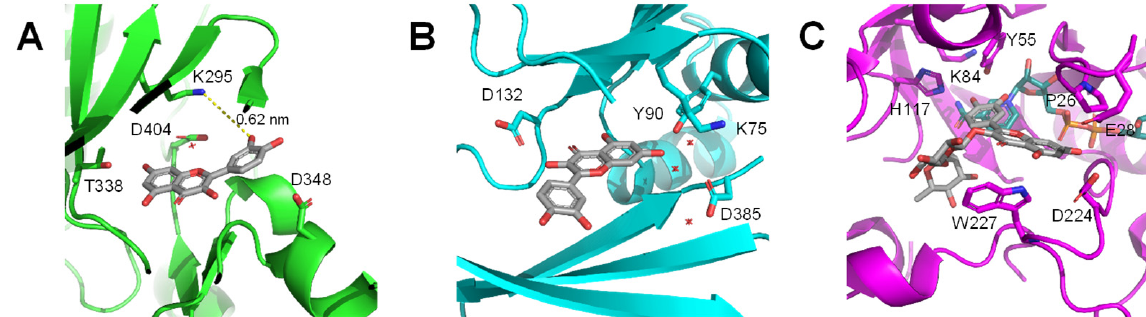
Figure 5. Interactions between flavonoid ligands and proteins from X-ray crystal structures; residues that could either form adducts or be oxidized by flavonoids are labeled. ( A ) the tyrosine kinase Hck (green) with quercetin (gray) (PDB 2HCK). The distance from K295 to the catechol group of quercetin is within a reasonable distance for electron transfer; ( B ) human inositol polyphosphate multikinase (IMPK; cyan) with quercetin (gray) (PDB 6M89); ( C ) prostaglandin F synthase (magenta) with NADPH (cyan) and the quercetin-3- O -glycoside rutin (gray). In all three images, water molecules are shown as red asterisks.